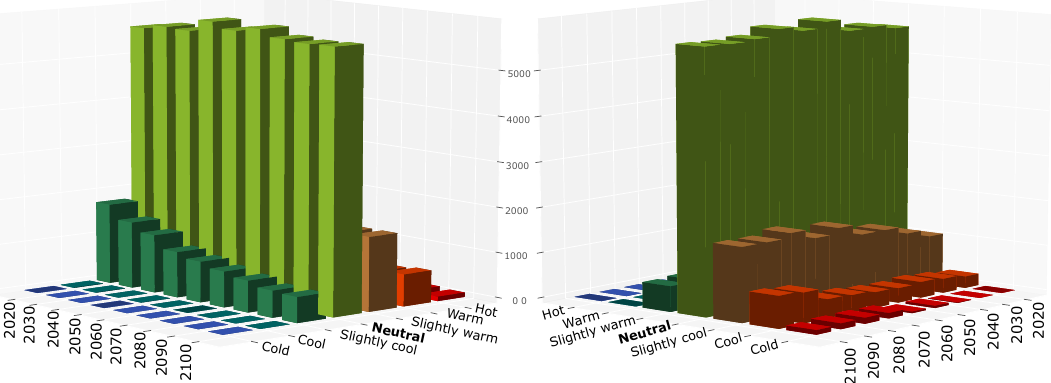
Figure A3. Comfort results taking into account the CTE-2019 standard and the Pamplona weather file generated with Meteonorm based on the IPCC scenario (1AB).